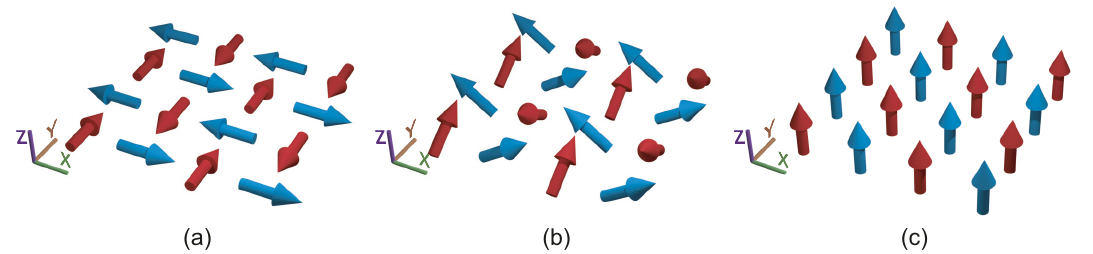
Figure 2 . The spin structure of the superfluid (SF) states in the classically U(1) degenerate manifold at several representative φ . (a) φ = π/ 4 (coplanar), (b) φ = π/ 10 (non-coplanar), (c) φ = 0 (collinear) ferromagnetism (FM), respectively. The order from the quantum disorder (OFQD) effect selects φ = π/ 4 as the true quantum ground state, which has the 4-sublattice coplanar 90 ◦ frustrated spin structure given by eq. (2.14). If changing the sign of the OFQD term, then it becomes the FM SF state (See ref.